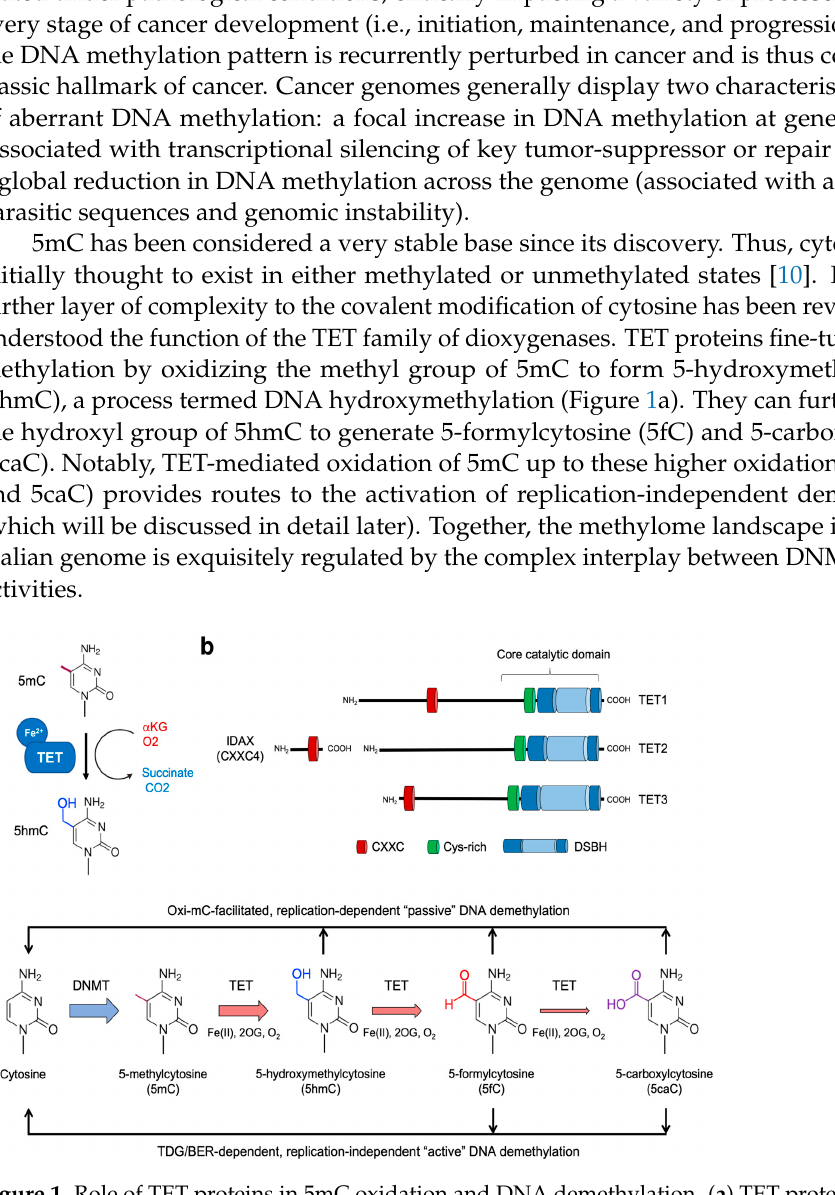
Figure 1. Role of TET proteins in 5mC oxidation and DNA demethylation. ( a ) TET proteins belong to the family of Fe 2+ - and α KG-dependent dioxygenases that oxidize their substrates. All three TET family members successively oxidize 5mC to 5hmC, 5fC, and 5caC. ( b ) Proteins of the TET family consist of TET1, TET2, and TET3. All three TET proteins have highly conserved catalytic domains at the carboxyl-terminal region, which is composed of the Cys-rich (Cys) and double-stranded β -helix (DSBH) domain. While TET1 and TET3 have the CXXC domain at their amino-terminal regions, TET2 does not contain it. Instead, during evolution, the chromosomal inversion separated the region encoding the CXXC domain of primordial TET2 from that encoding its catalytic domain, giving rise to a unique gene IDAX (which is also called CXXC4 ). ( c ) DNMTs methylate cytosine to yield 5mC, which is further oxidized by TET proteins. The oxidized methylcytosines (called oxi-mCs) interfere with DNMT1, thus promoting “passive” DNA demethylation after replication. Moreover, 5fC and 5caC are recognized and cleaved by the DNA repair protein TDG. Then, the resultant abasic sites are repaired by the base-excision repair (BER) pathway, a process called replication-independent “active” DNA